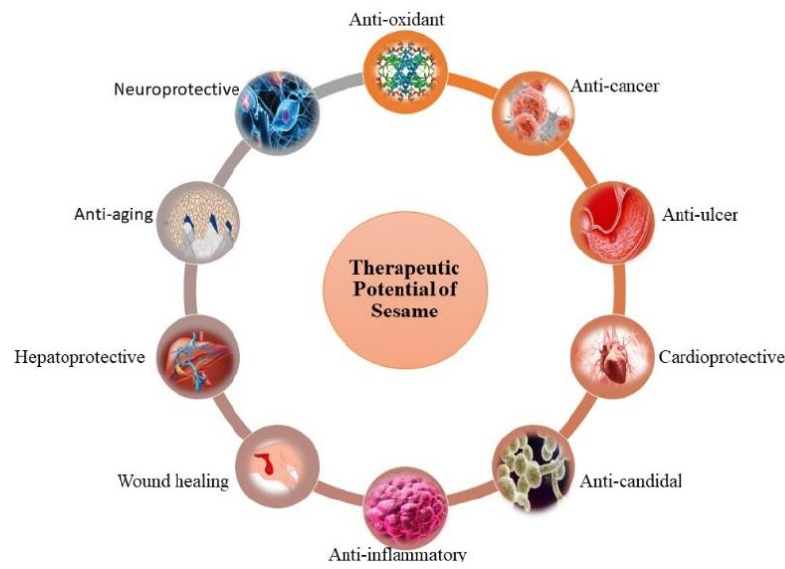
Figure 3. Therapeutic potential of sesame.